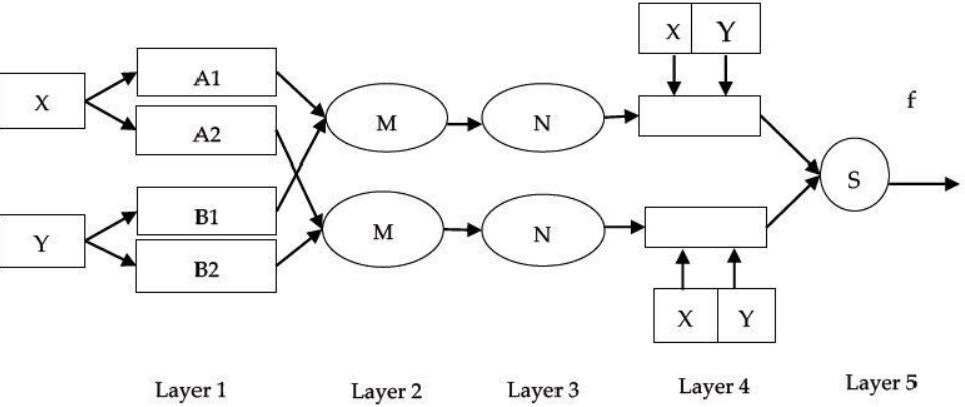
Figure 1. Fundamental Model of Adaptive Neuro-Fuzzy Inference System (ANFIS).